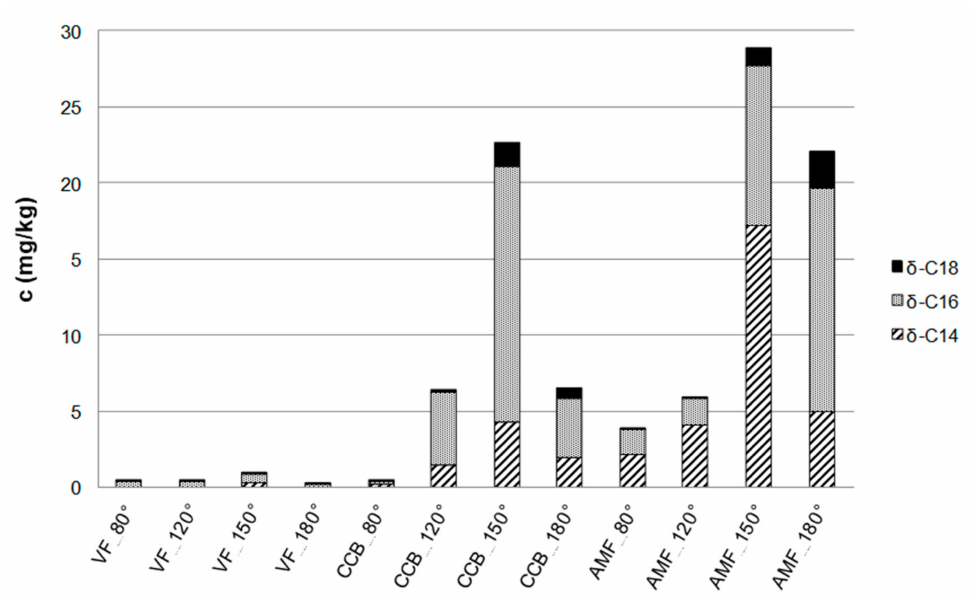
Figure 5. Concentrations of δ -tetra- ( δ -C14), δ -hexa- ( δ -C16), and δ -octadecalactone ( δ -C18) in the semi-volatile isolate obtained by high-vacuum distillation at 80/120/150/180 ◦ C of cocoa butter (CCB), anhydrous milk fat (AMF), and vegetable fat (VF) after removal of triglycerides determined by means of LC–MS/MS. (SD < 10%).